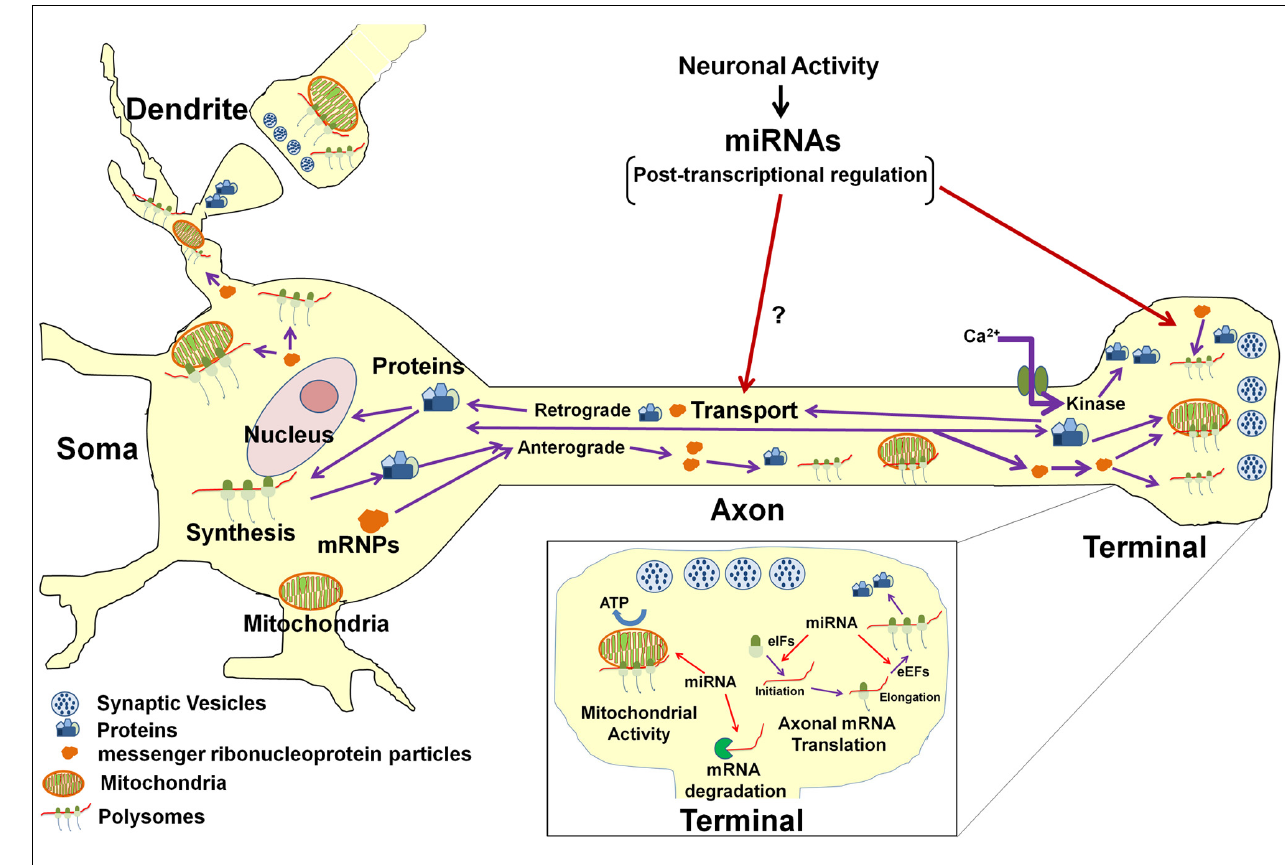
expression of specific target mRNAs that encode factors affecting mitochondrial activity (see inset) as well as axonal growth and branching. In addition, miRNAs can also modulate translation of multiple mRNAs in the axon and nerve terminal by regulating local expression of eukaryotic translation factors (see inset). It is also conceivable that miRNAs might regulate the local synthesis and retrograde transport of transcription factors in response to growth factors or neural injury and hence influence gene transcription in the parental soma. Last, miRNA control of the local synthesis of cytoskeletal and/or motor proteins might facilitate the regulation of their own anterograde transport to their ultimate sites of